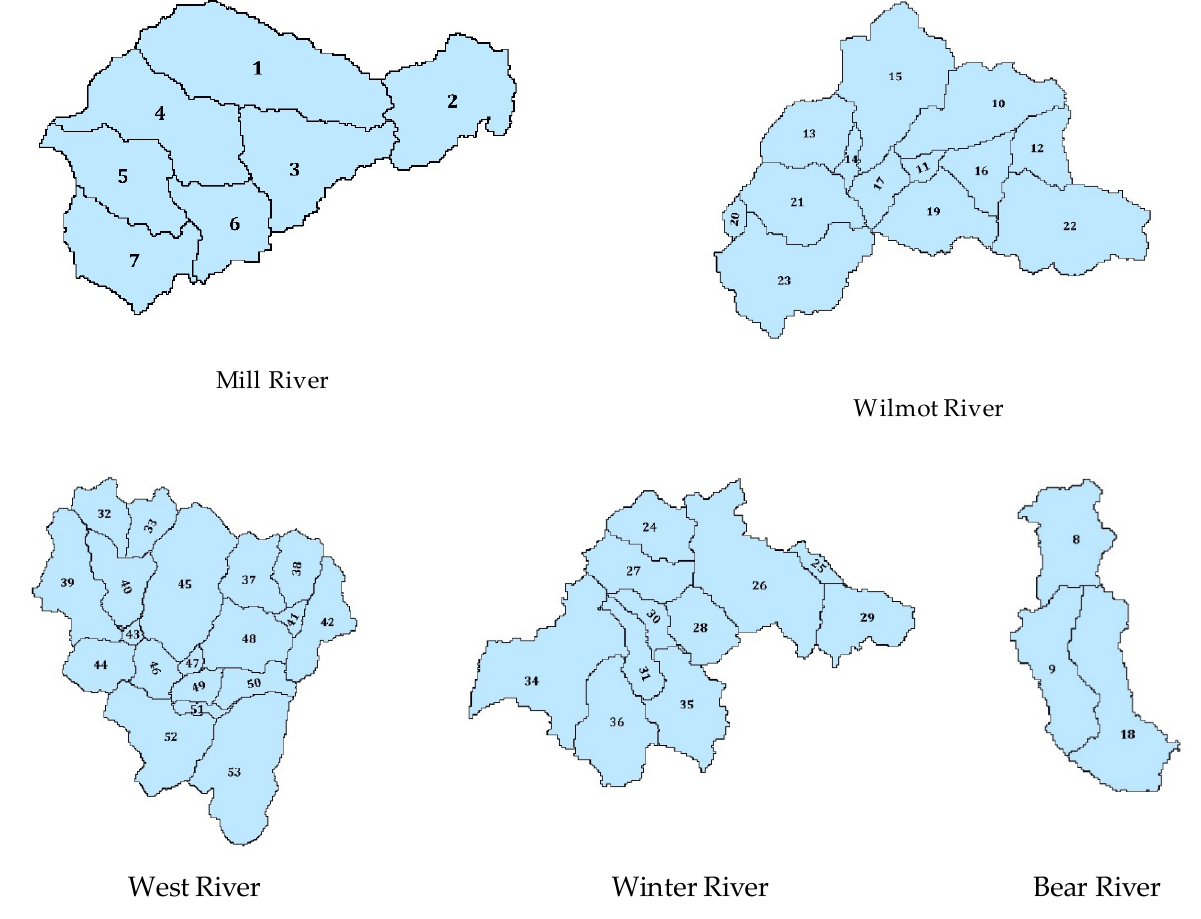
Figure 2. Subbasins of different watersheds modeled by SWAT.